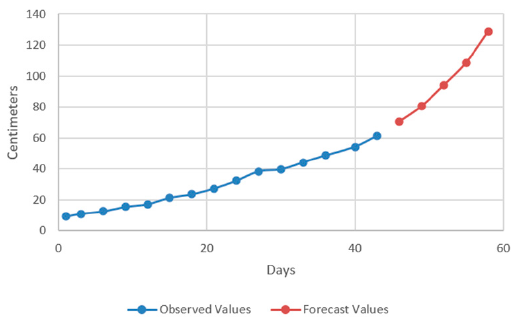
Figure 10. The evolution of basil shoot height in AR experimental variant.